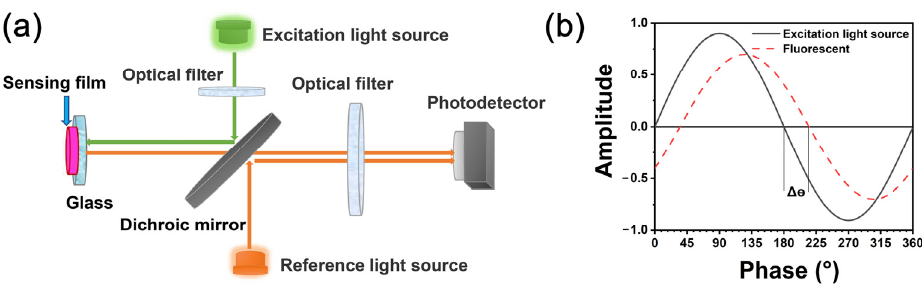
Figure 1. ( a ) Schematic diagram of fluorescence sensor; ( b ) principle of phase delay method.